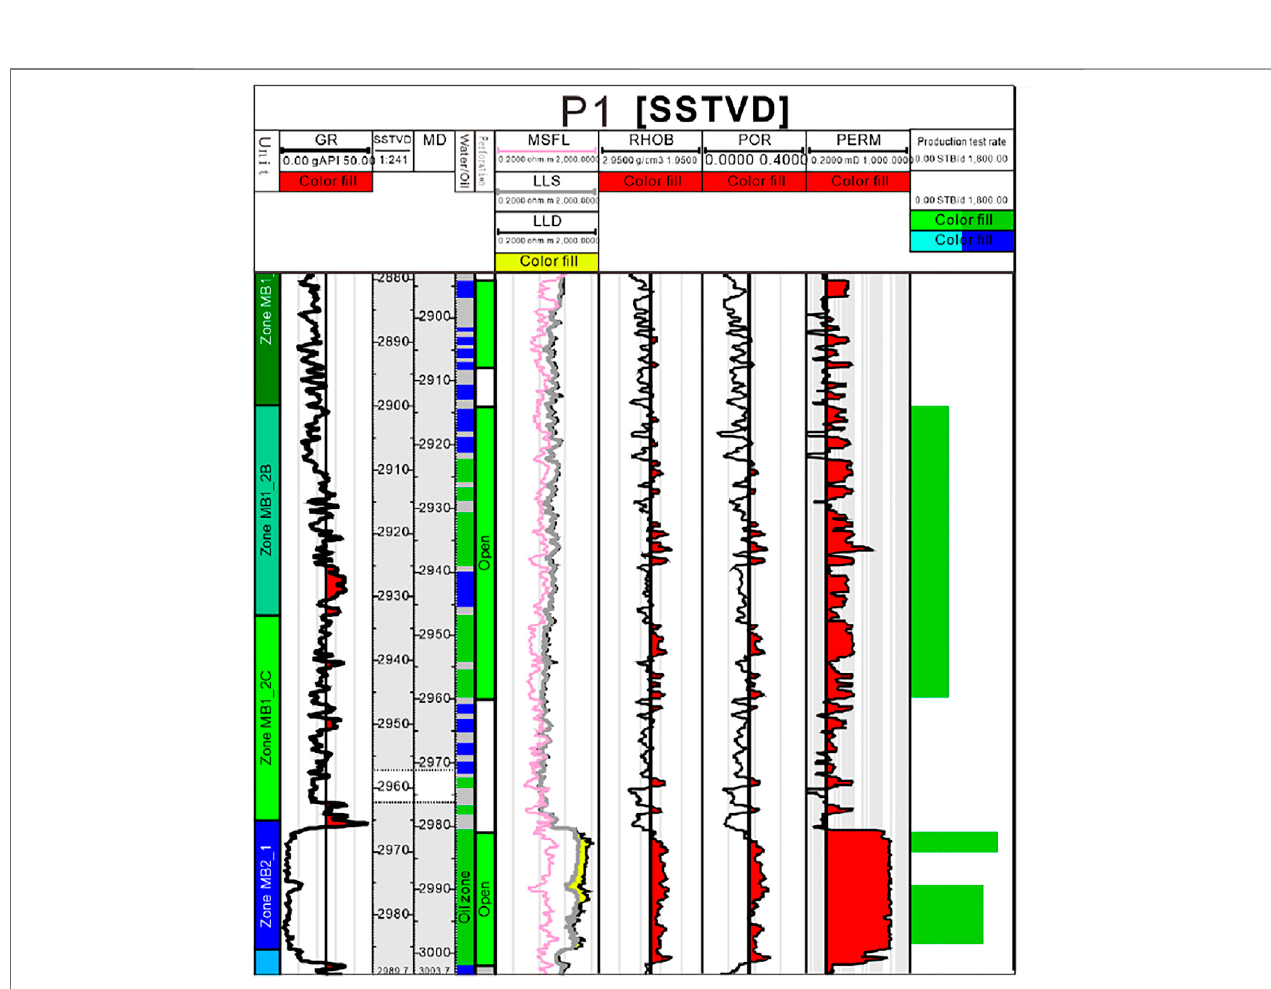
FIGURE 5 | The fi gure of the production pro fi le of P1